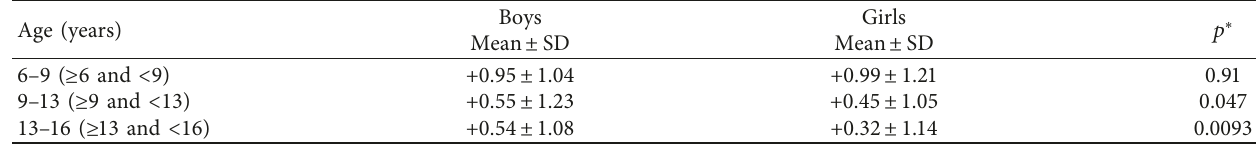
Table 2: Spherical equivalent ( D ) among examined boys and